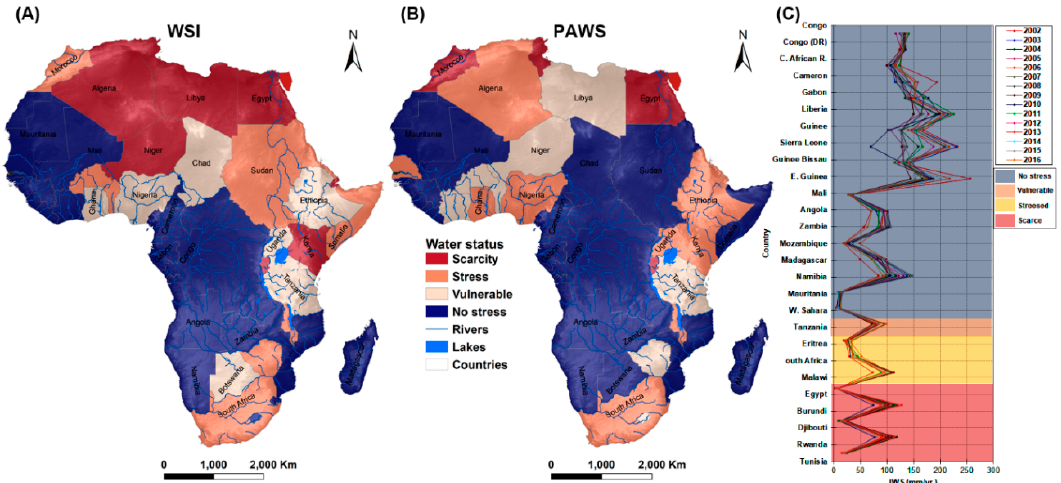
Figure 5. Water Stress Index based on the current AQUASTAT water storage data ( A ), and the new proposed Potential Available Water Storage (PAWS) from Gravity Recovery and Climate Experiment (GRACE) data ( B ) using the average Internal Water Storage (IWS) from 2002 to 2016. The plot ( C ) shows the changes in the IWS for 26 countries between 2002 and 2016 that are agreed on the water status level, (“no stress” 18 countries, “vulnerable” one country, “Stressed” three countries, and “Scarce” four countries).